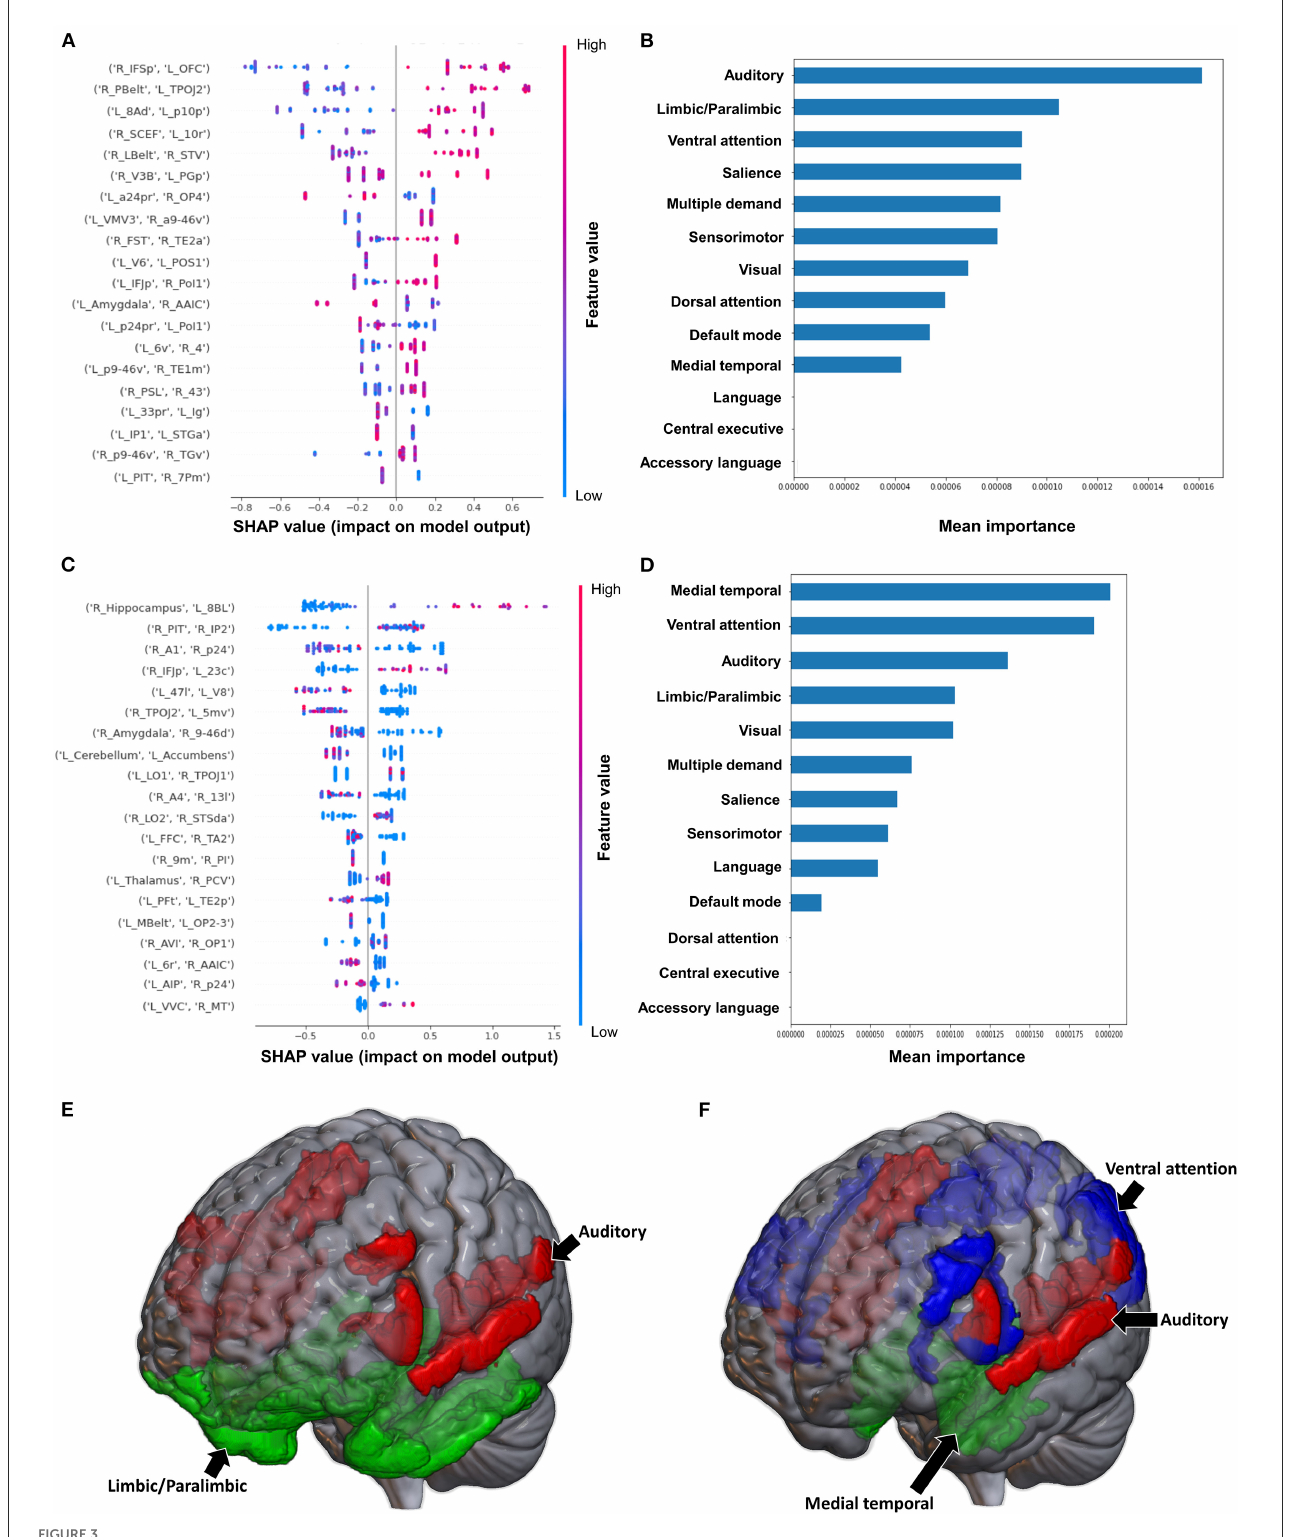
FIGURE3 Feature Importance Analysis of the models classifying the Fugl Meyer assessment—upper extremity based on functional connectivity at the (A) individual brain region level, and (B) the network level; and based on structural connectivity at the (C) the individual brain region level, and (D) the network level. The networks contributing most to the models’ classifications, based on (E) functional connectivity, and (F) structural connectivity, have also been visualized on brain